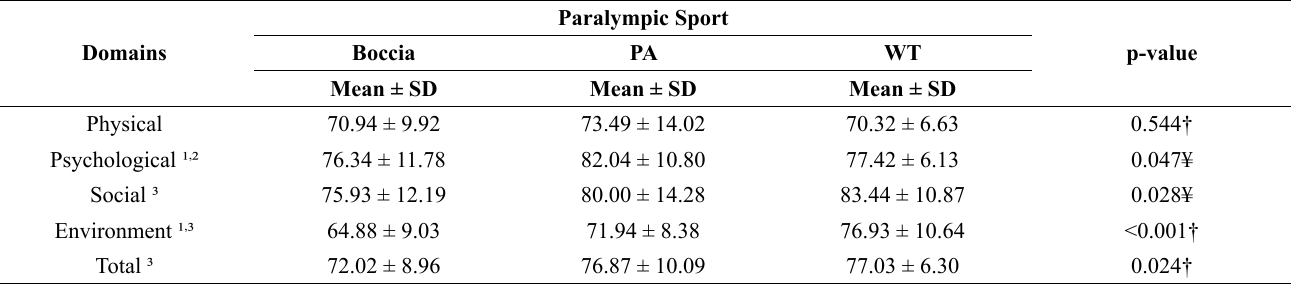
Table 4. Perception reported according to the Paralympic Sport practiced and the domains of